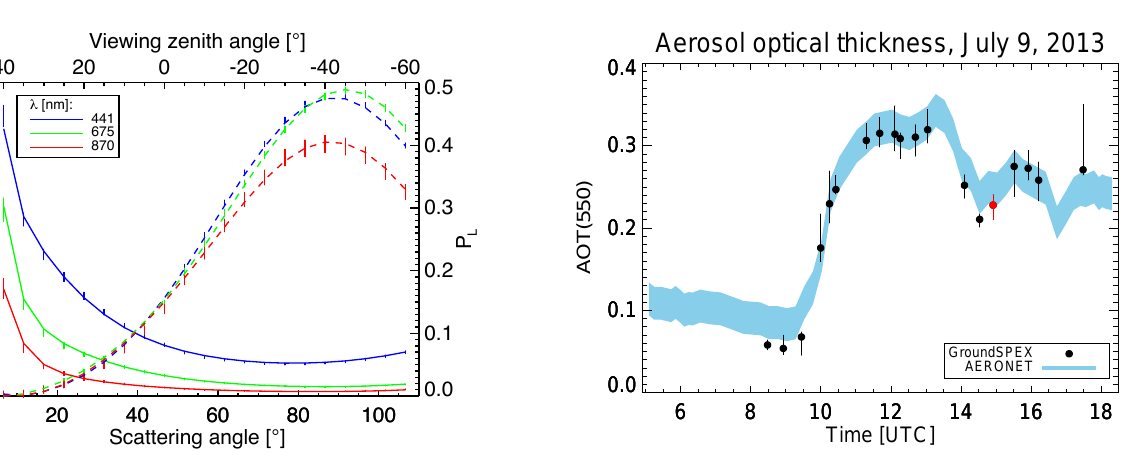
Figure 5. Measurements (displayed as vertical error bars) and re- trieval algorithm best fit of spectral radiance (solid curves) and de- gree of linear polarization (dashed curves) as a function of scatter- ing angle in the principal plane. The mean solar zenith angle was 46.66 ◦ , with a drift of < 0 . 03 ◦ during the measurements. CESAR Observatory, 9 July 2013, 14:55UTC.